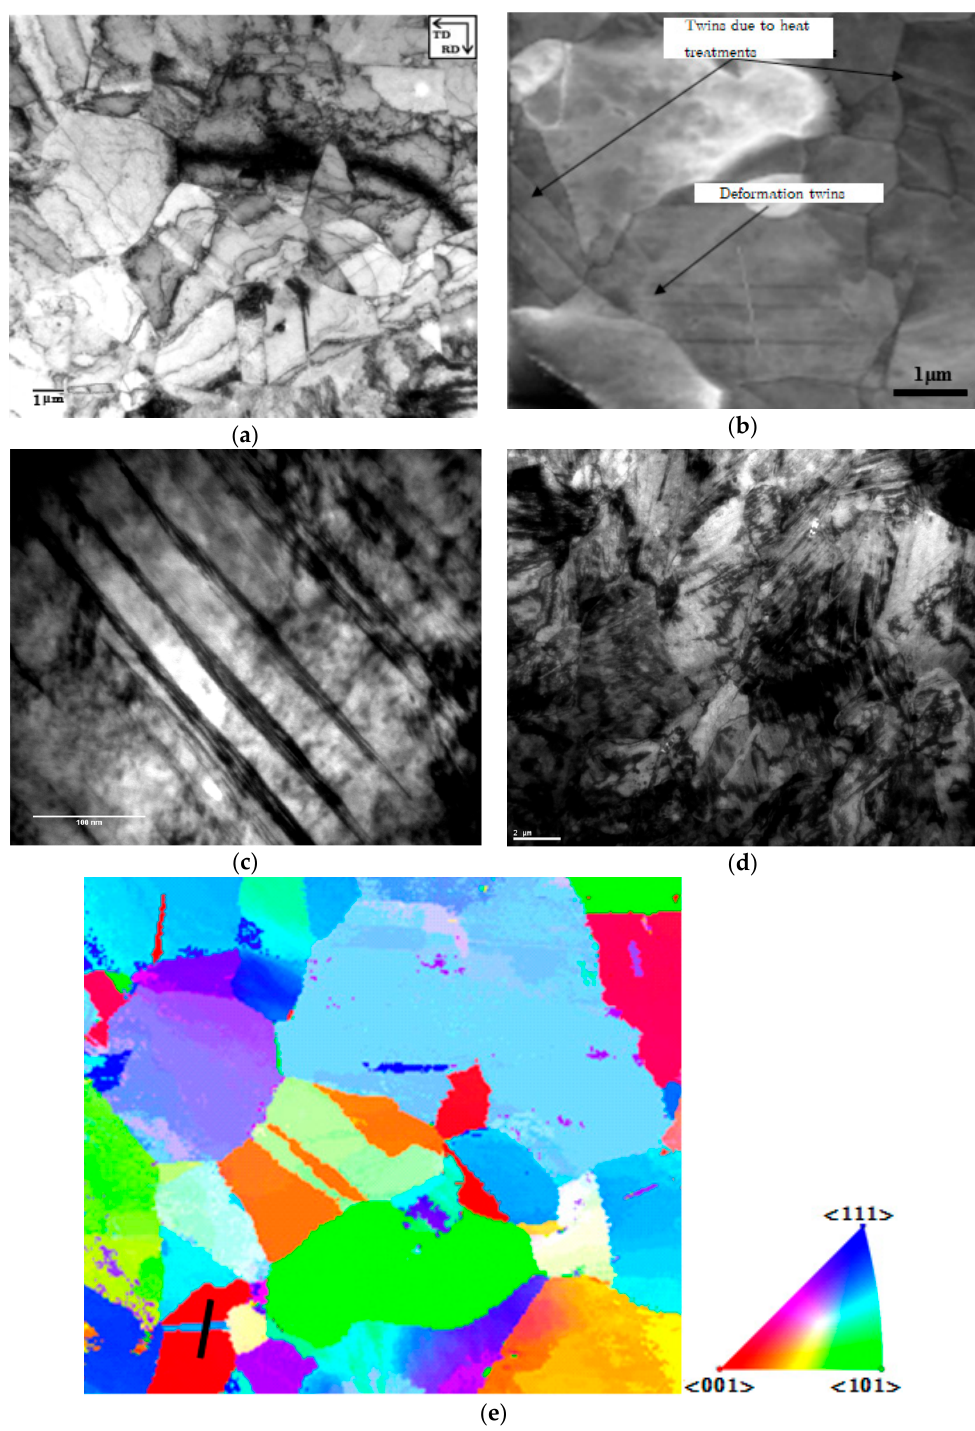
Figure 13. Transmission electron microscopy (TEM) images of ( a ) an undeformed sample; ( b ) a 10% deformed sample; ( c ) a 20% deformed sample; ( d ) a deformed sample until maximum force was reached (true strain of 40%); ( e ) grains orientation and texture of an undeformed sample.